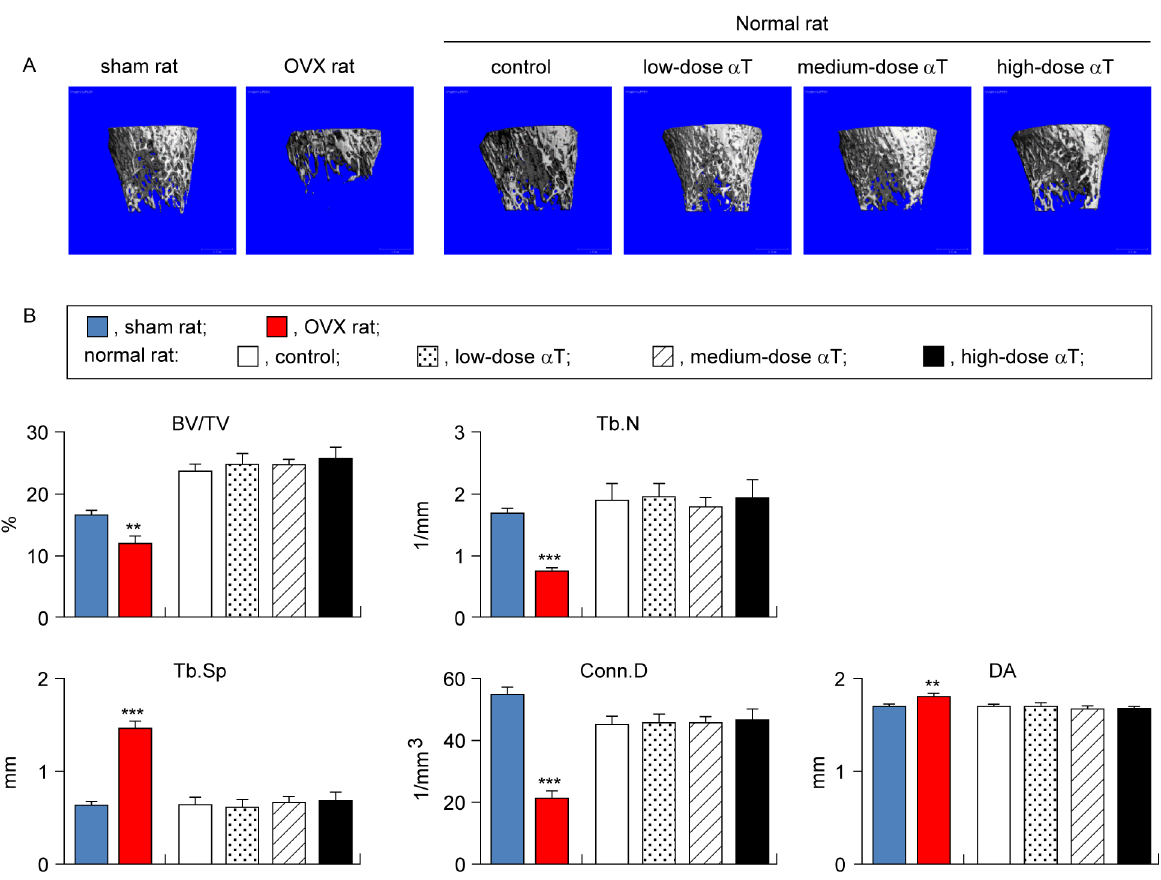
Fig 3. Micro-CT analysis of trabecular bones in distal femur metaphysis. (A) Representative 3-dimensional micro-CT images of trabecular bones in distal femur metaphysis are shown. (B) Microstructural parameters (BV/TV, trabecular bone volume fraction; Tb.N, trabecular number; Tb.SP, trabecular separation; Conn.D, connectivity density; DA, degree of anisotriphy) of trabecular bones in distal femur metaphysis are shown. Data are presented as mean ± standard error of the mean. ** P < 0.01, *** P < 0.001 vs. sham rat group.